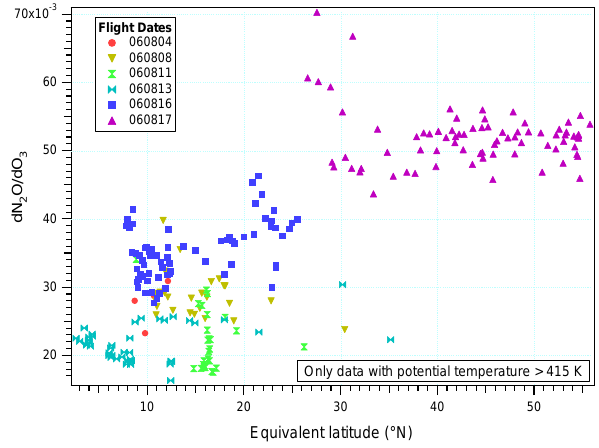
Fig. 11. Slope dN 2 O/dO 3 against equivalent latitude for the AMMA/SCOUT-O3 flights.